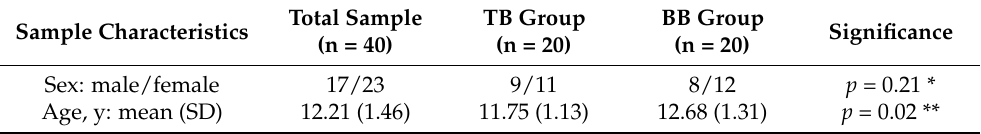
Table 2. Demographic characteristics of the study sample.